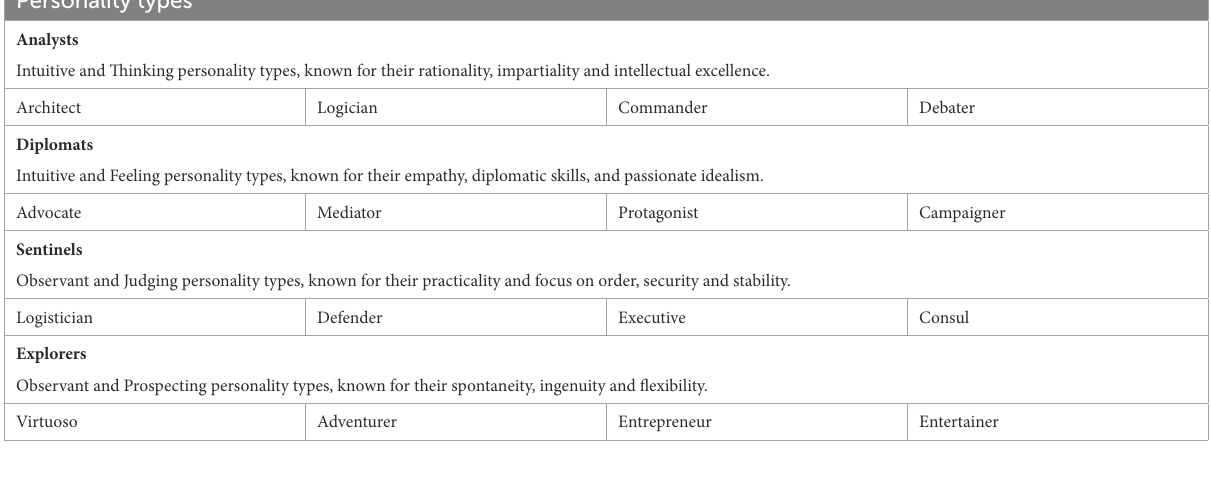
TABLE 2 Test 16 personalities.